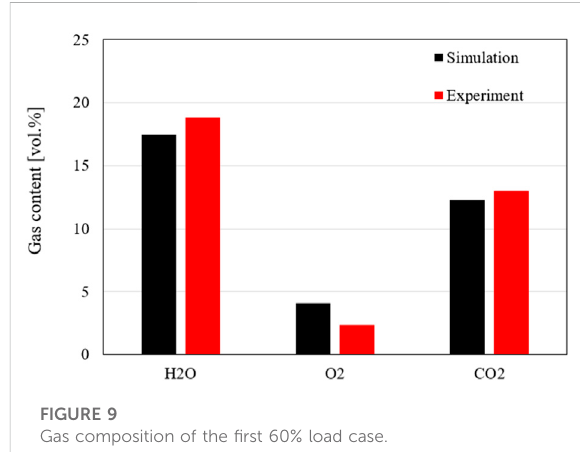
FIGURE 9 Gas composition of the fi rst 60% load